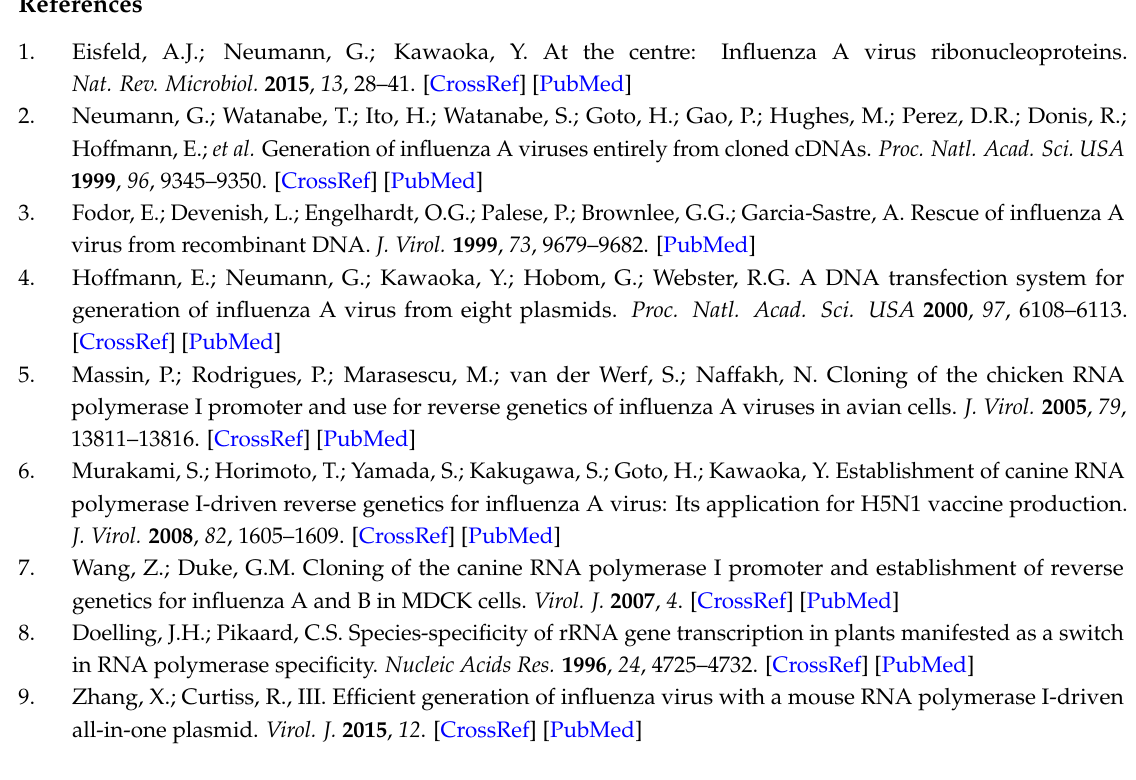
Figure S1: Graphical representation of the construction strategy for pLW1000-NPluci, pLW750-NPluci, pLW500-NPluci, pLW250-NPluci, pLW125-NPluci, and pLW0-NPluci, Table S1: The detailed information on the primers used to construct pLW1000-NPluci, pLW750-NPluci, pLW500-NPluci, pLW250-NPluci, pLW125-NPluci, and